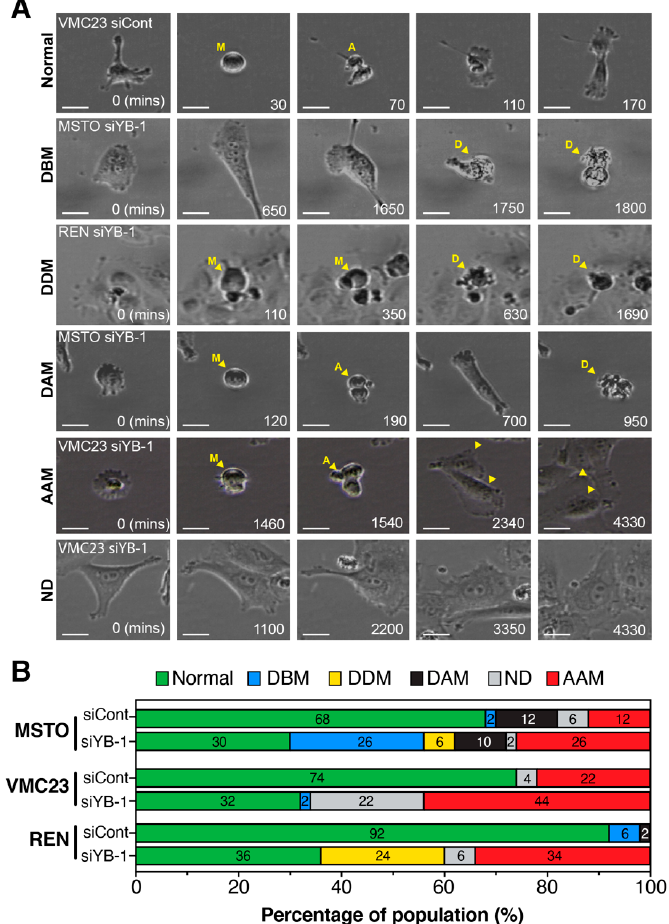
Figure 8. Live cell imaging of YB-1 knockdown phenotypes ( A ) Representative images and ( B ) quantification of cells transfected with either Control (siCont) or YB-1 siRNA (siYB-1 #1) monitored for 72 h (time in min) by time-lapse microscopy and scored based on observed phenotype. Normal (2 + ) = cells that underwent two or more mitoses and remained viable. DBM = cells that died before undergoing any mitosis. DDM = cells that died during mitosis. DAM = cells that died after a mitosis. AAM = cells that arrested after mitosis and did not divide again. No division (ND) = cells that did not divide at all during 72 h. Times (bottom right) are in minutes. M = mitosis, A = anaphase, D = cell death. Scale bars = 20 µ